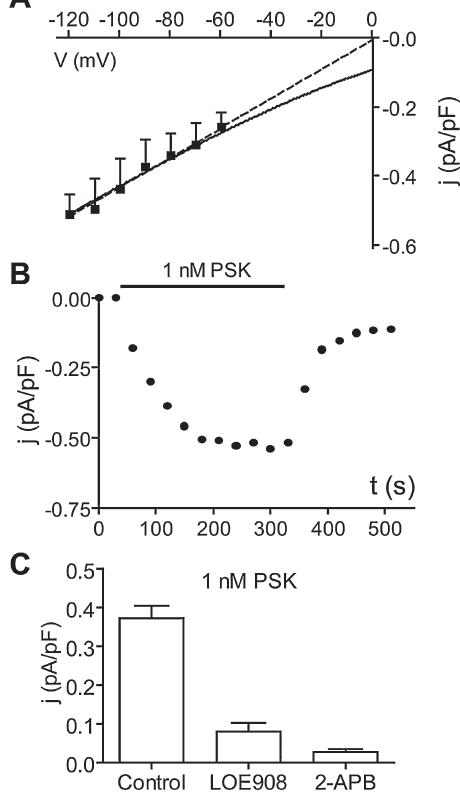
Figure 7. PSK reduces the Ca 2 þ background current . ( A ) Current density– Voltage (j–V) relationship of the current reduced by 1nM PSK (difference current: Control (cid:1) 4minutes PSK). Currents were measured at the end of 40ms lasting voltage jumps from (cid:1) 120mV to (cid:1) 60mV (holding potential (cid:1) 50mV) and normalized by membrane capacitance of cells. Data, means of six cells. Dashed line, linear approximation; solid curve, fit of GHK model for a Ca 2 þ conductance. ( B ) Typical time course of the reduction of membrane current density upon application of 1nM PSK and recovery upon washing off the peptide. ( C ) Current density of the current reduced by 1nM PSK at (cid:1) 90mV (obtained as in A) alone (Control) and after preincubation of cells LOE908 (10 m M) or 2-APB (100 m M). Data, means of six cells; bars, SEM